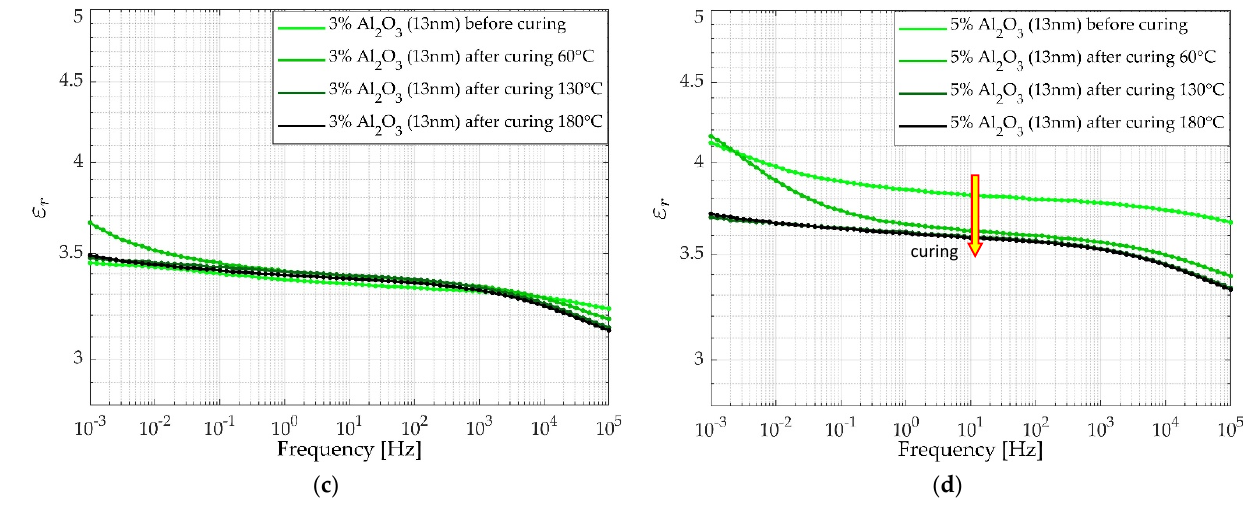
Figure 5. Broadband dielectric constant ε r ( f ) characteristics for samples with Al 2 O 3 , with particles of 13 nm and different wt% loadings: ( a ) 0.5%, ( b ) 1%, ( c ) 3%, ( d ) 5%.